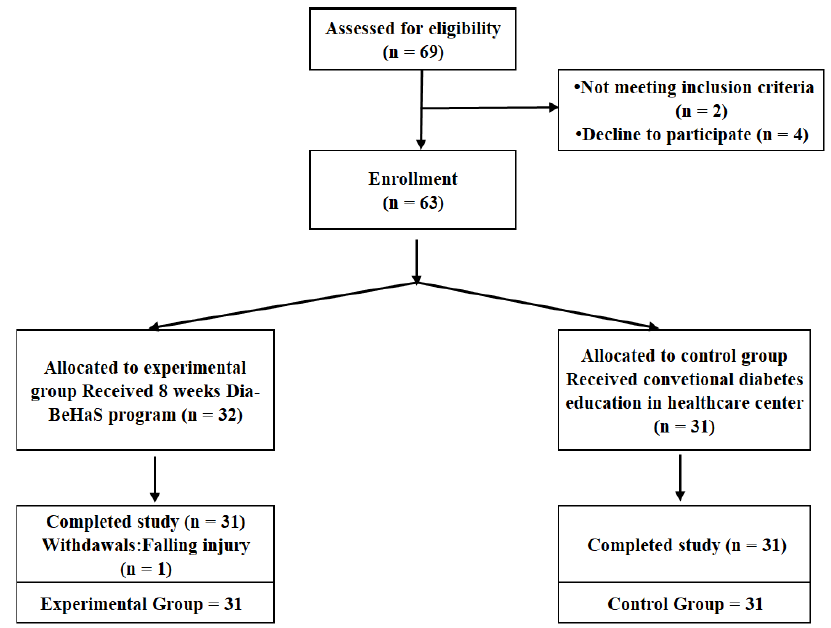
Figure 1. Participant flow